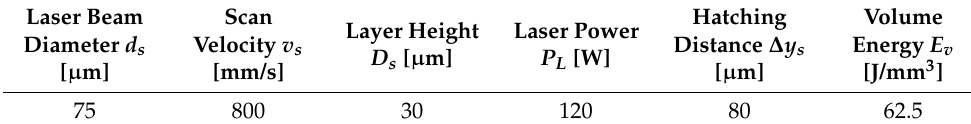
Figure 2. Test geometry in ( a ) top view, ( b ) front view, and ( c ) orientation on the building platform. The parts were manufactured using Sandvik 17-4ph powder with particle size range 1–20 µ m. The laser parameters used are shown in Table 3, below. The laser configuration was selected from previous experiments and optimized for the used material. According to data preparation, 8 scan vector orientations were applied during the print job with 67.5-degree intervals. The camera images of part 1 (in Figure 3) show different scan vectors can influence the performance of monitoring results with higher or lower gray value on the printed area. Table 3. Laser parameter for experiment.